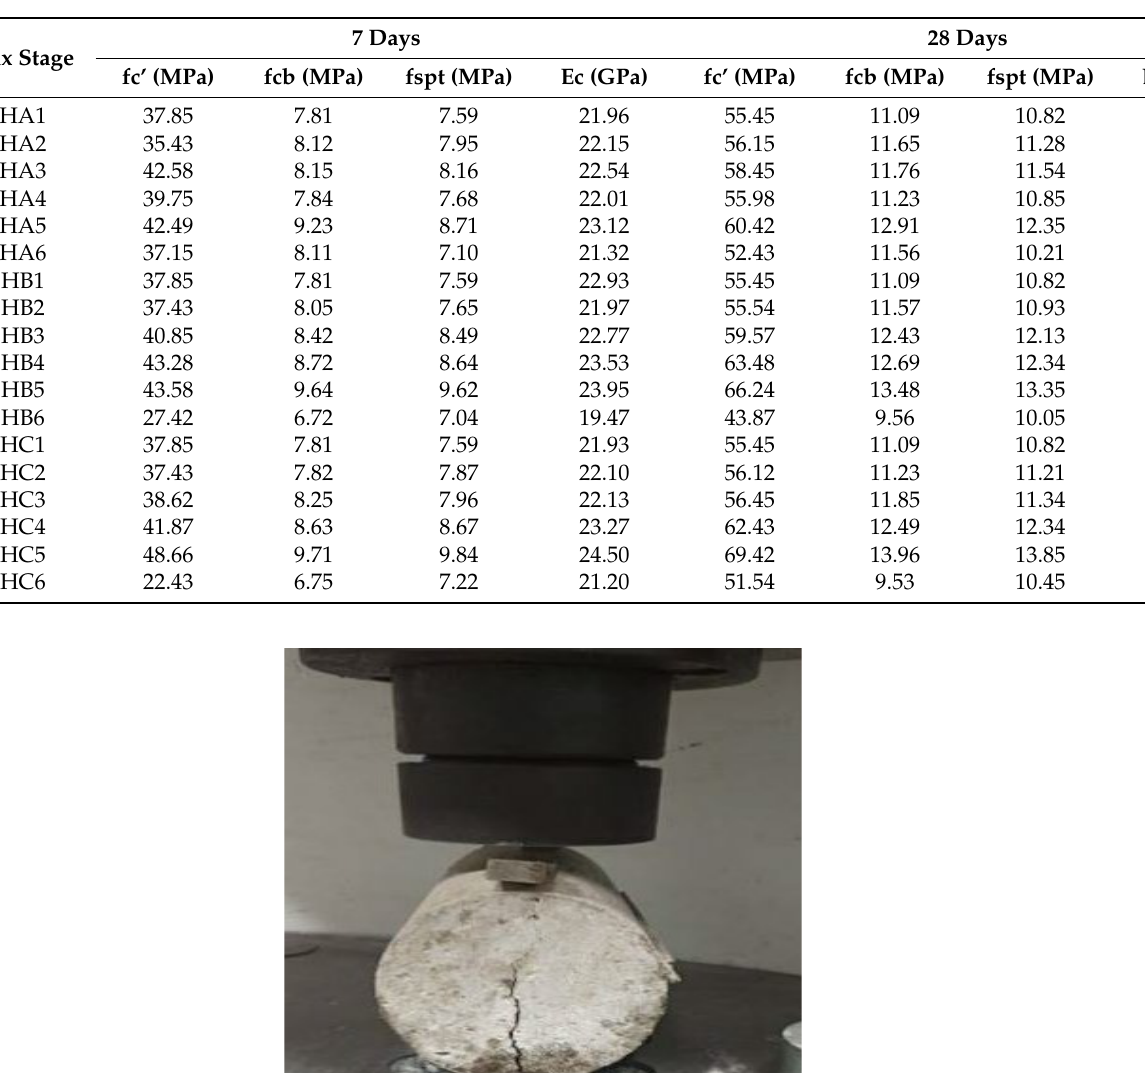
Table 6. Experimental results for fc’, fcb, fspt, and Ec.